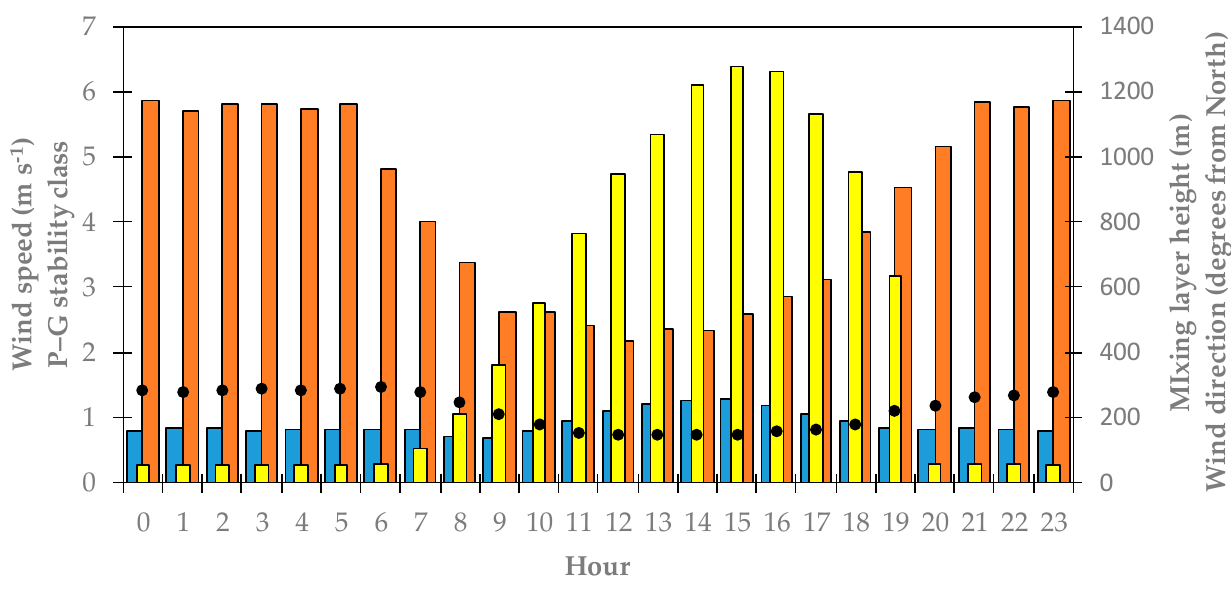
Figure 3. Average daily patterns of wind speed (blue bars, left axis), atmospheric stability (orange bars, left axis, P–G classes: class A = 1, class F = 6), wind direction (black dots, right axis), mixing layer height (yellow bars, right axis) for the simulation reference period.